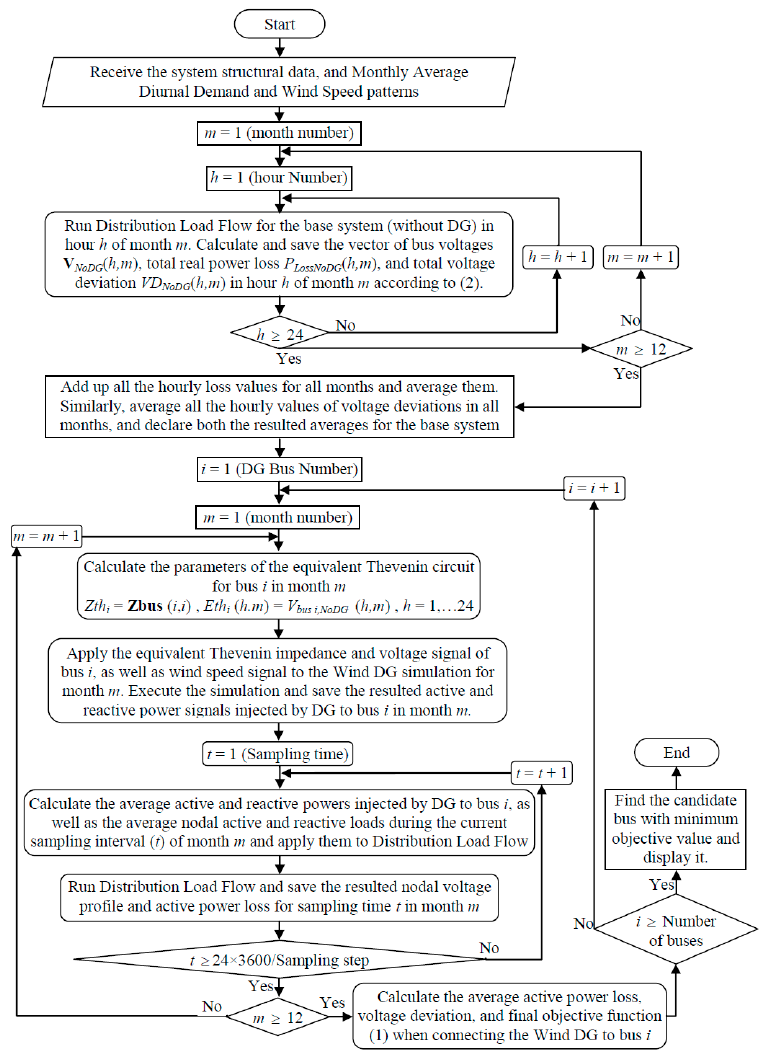
Figure 5. Flowchart of the proposed WDG placement algorithm.